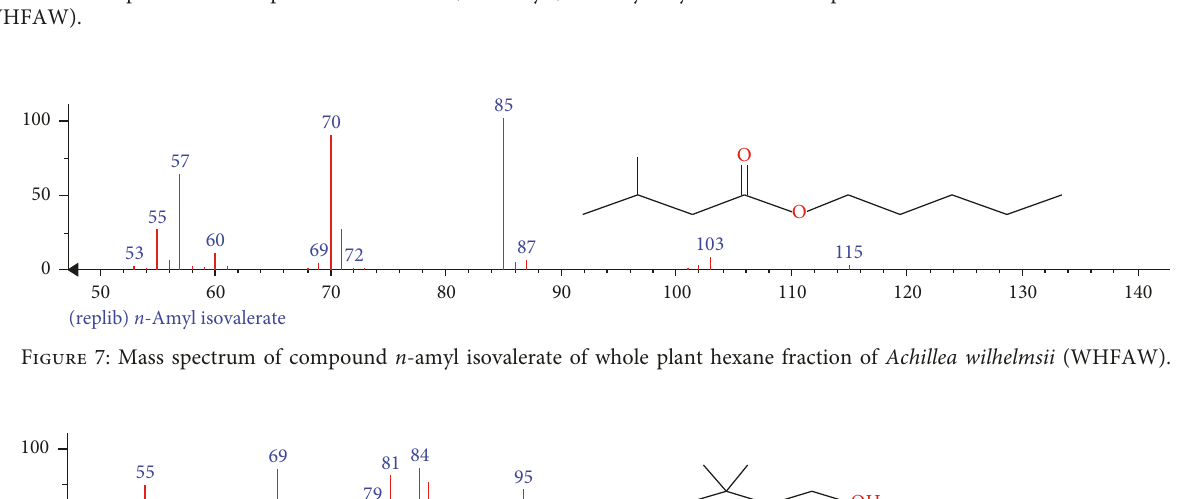
ester50 (mainlib) Butanoic acid, 2-methyl-, 2-methylbutyl Figure 6: Mass spectrum of compound butanoic acid, 2-methyl-, 2-methylbutyl ester of whole plant hexane fraction of Achillea wilhelmsii (WHFAW).